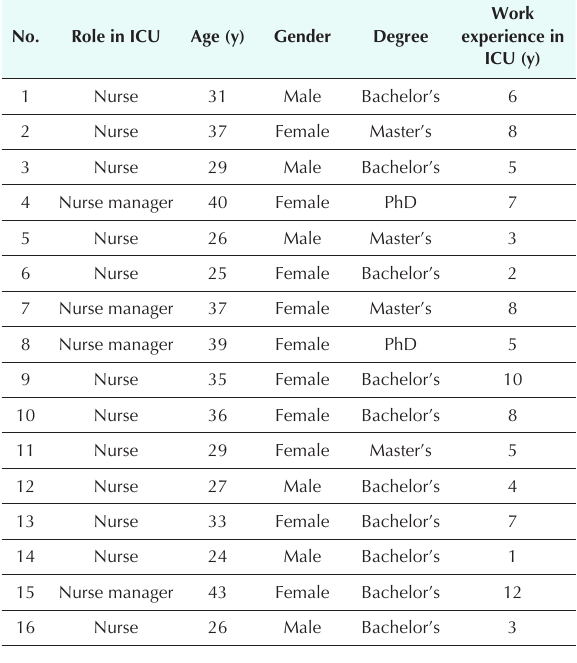
Table 1. Participants’ demographic characteristics No.